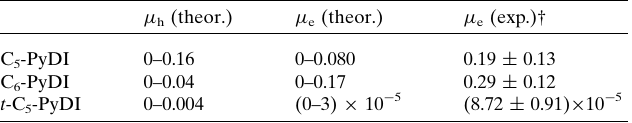
Table 3 Theoretical hole-diffusion mobilities ( (cid:3) h ) and electron-diffusion mobi-